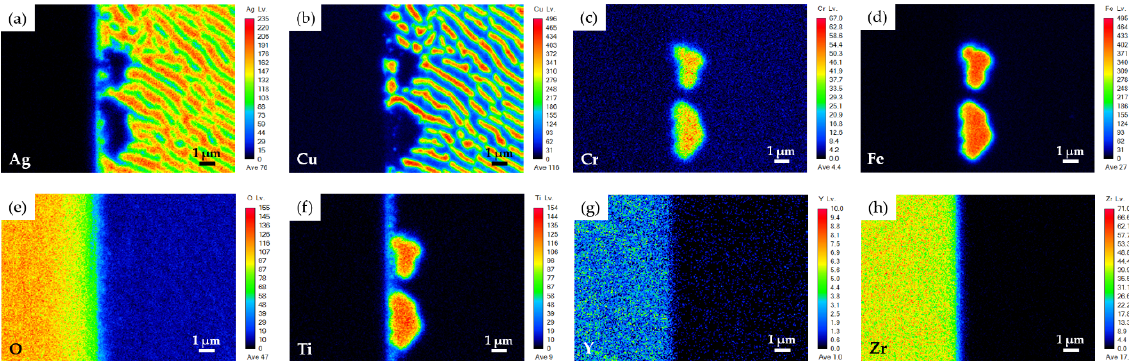
Figure 4. EPMA WDS element mappings of YSZ side in Figure 3c: ( a ) Ag, ( b ) Cu, ( c ) Cr, ( d ) Fe, ( e ) O, ( f ) Ti, ( g ) Y, and ( h ) Zr.